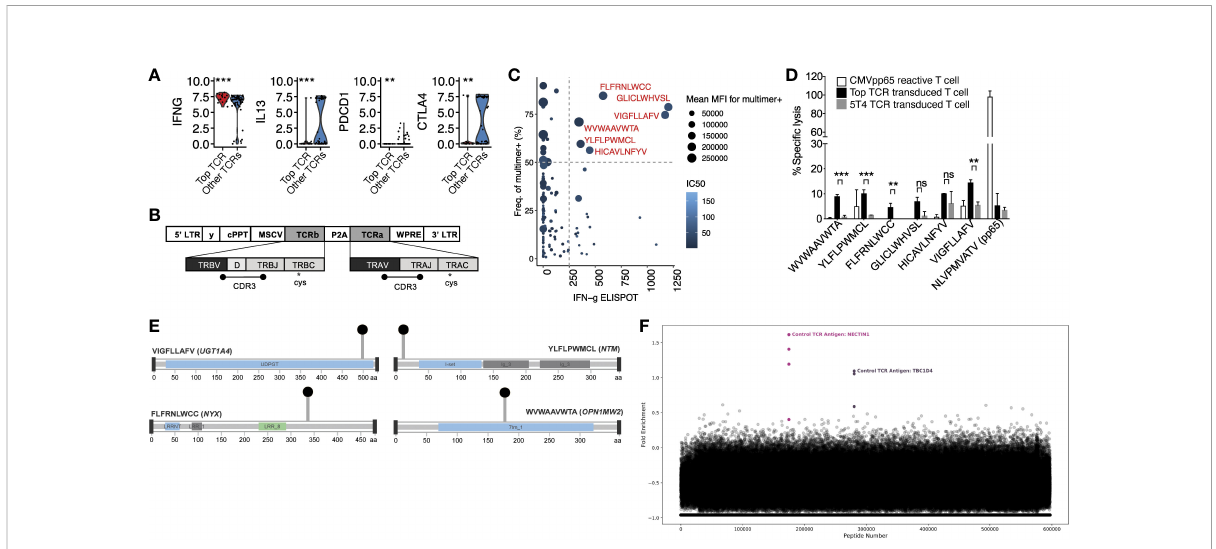
FIGURE 2 Phenotypic characterization and antigen speci fi city of the dominant T cell clone. (A) Differential gene expression from targeted scRNAseq comparing the dominant ( “ Top TCR ” ) to non-dominant clones. Signi fi cance was measured by T test. (B) Construction of TCR ab clone. (C) Interferon-gamma elispot in relation to mean fl uorescence intensity (MFI) of neopeptide generated tetramers. Dashed lines de fi ne threshold for reactive peptides (show in red) (D) Chromium release assay of candidate neopeptides. Mean with standard deviations are plotted along with the level of signi fi cance from T tests. (E) Lollipop plots showing the location of non-synonymous mutations within the protein amino acid sequence of candidate neoantigens. (F) T-Scan results showing the fold enrichment of each protein fragment in the T-Scan peptidome library. Each point represents an individual protein fragment. Enriched protein fragments with a common epitope are highlighted and labeled. ns: P > 0.05, *P ≤ 0.05, **P ≤ 0.01, ***P ≤